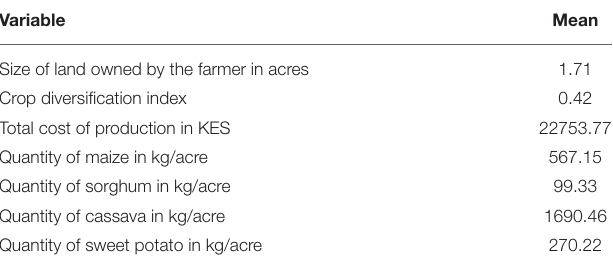
TABLE 3 | Summary statistics of key variables used in translog cost function